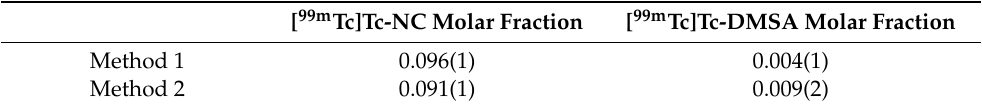
Table 6. Amount of 99m Tc atoms bound to NC or to DMSA reported as molar fraction. Mean